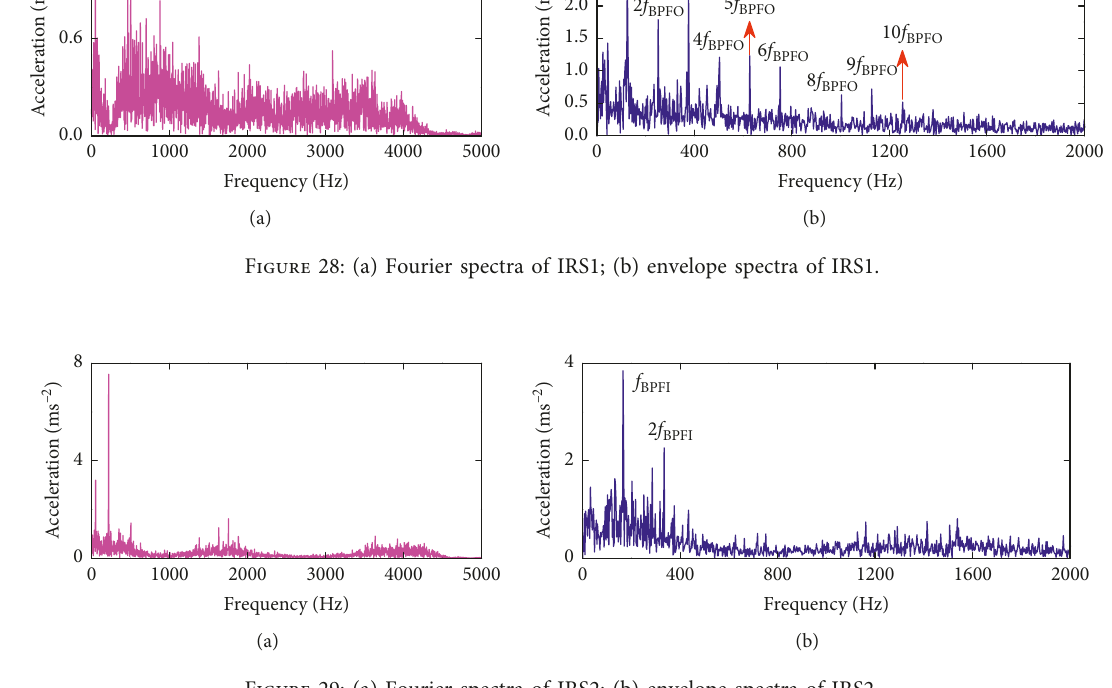
Figure 29: (a) Fourier spectra of IRS2; (b) envelope spectra of IRS2.